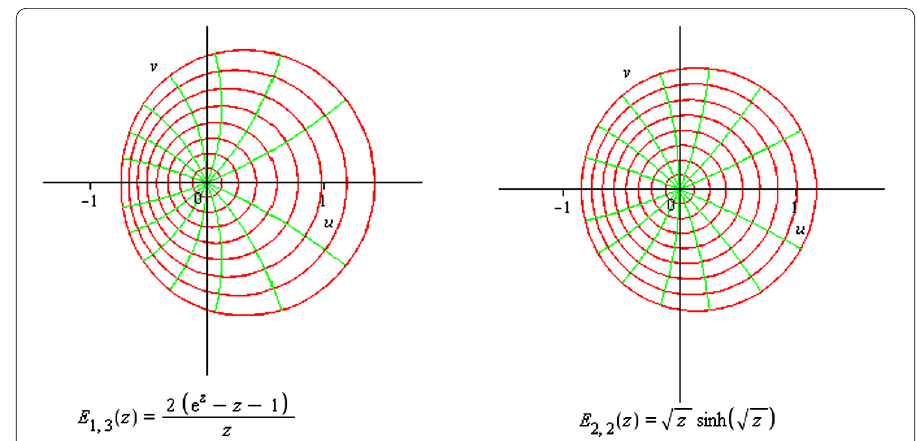
Example 3.7 For α = 1, β = 3, we have Γ ( α + β ) 2( e z – z – 1) E 1,3 ( z ) = z is in S ∗ ( 1 2